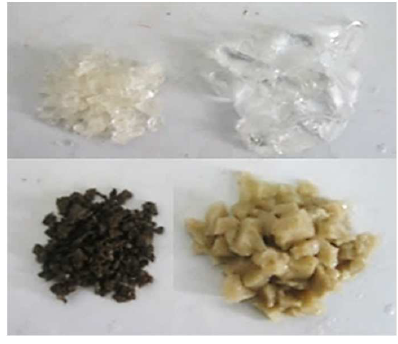
Figure 17. Comparison of SP before and after expansion.